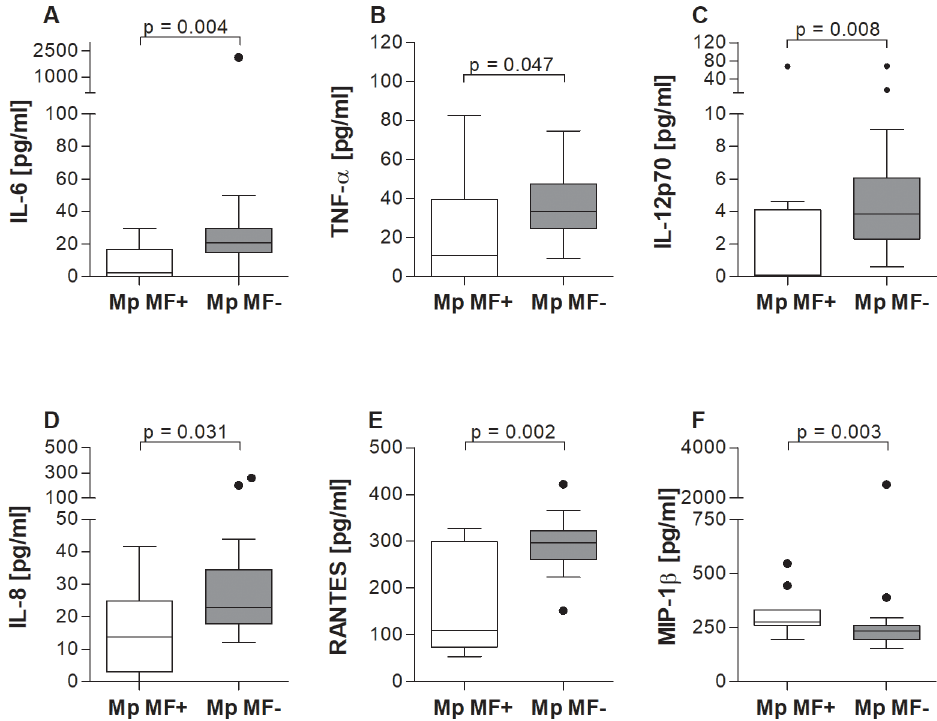
Fig 2. Elevated systemic levels of MIP-1 β levels in M . perstans microfilaremic individuals. Sera from M . perstans microfilaremic (Mp MF+, n = 11) and amicrofilaremic (Mp MF-; n = 28) individuals were analyzed for the contents of ( A ) IL-6, ( B ) TNF- α ,( C ) IL-12p70, ( D ) IL-8, ( E ) RANTES and ( F ) MIP-1 β using luminex technology. Graphs show box whiskers with median, interquartile ranges and outliers. Statistical significances between the indicated groups were obtained using the